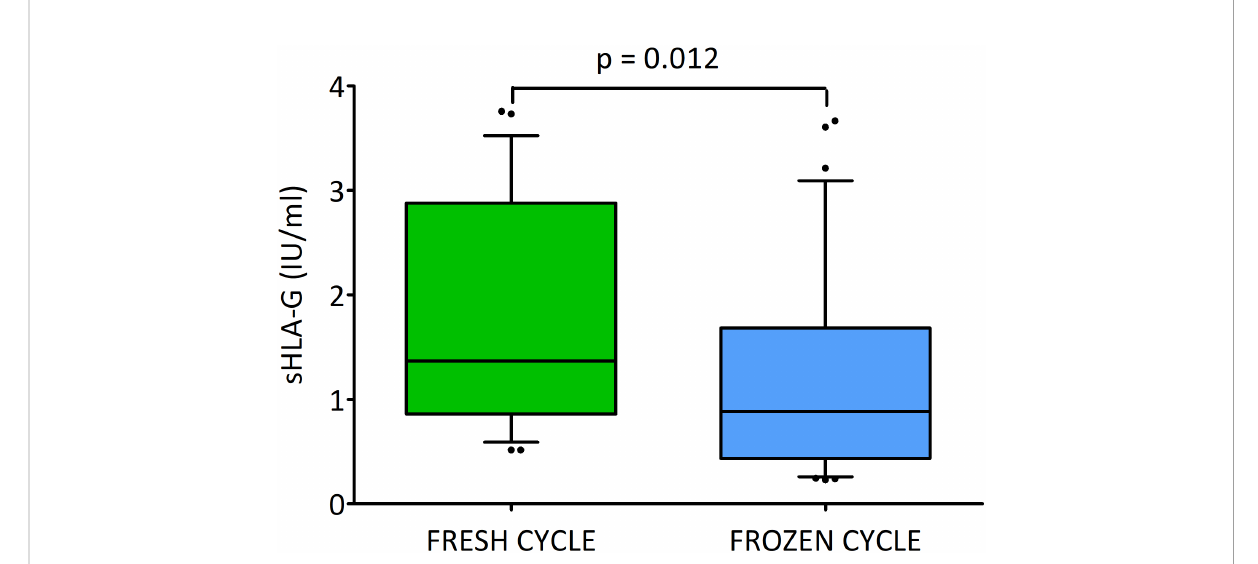
FIGURE 4 Secretion of soluble HLA-G (U/ml) by embryos in the fresh and frozen cycle. Green box represents the level of sHLA-G measured in embryo media in fresh cycle, blue box – in frozen cycle. Boxes are drawn from the fi rst quartile (25 th percentile) to the third quartile (75 th percentile). Black lines in boxes are medians. Whiskers represent 10-90 percentiles. P-values are calculated by Mann-Whitney test. Analysis do not include deferred